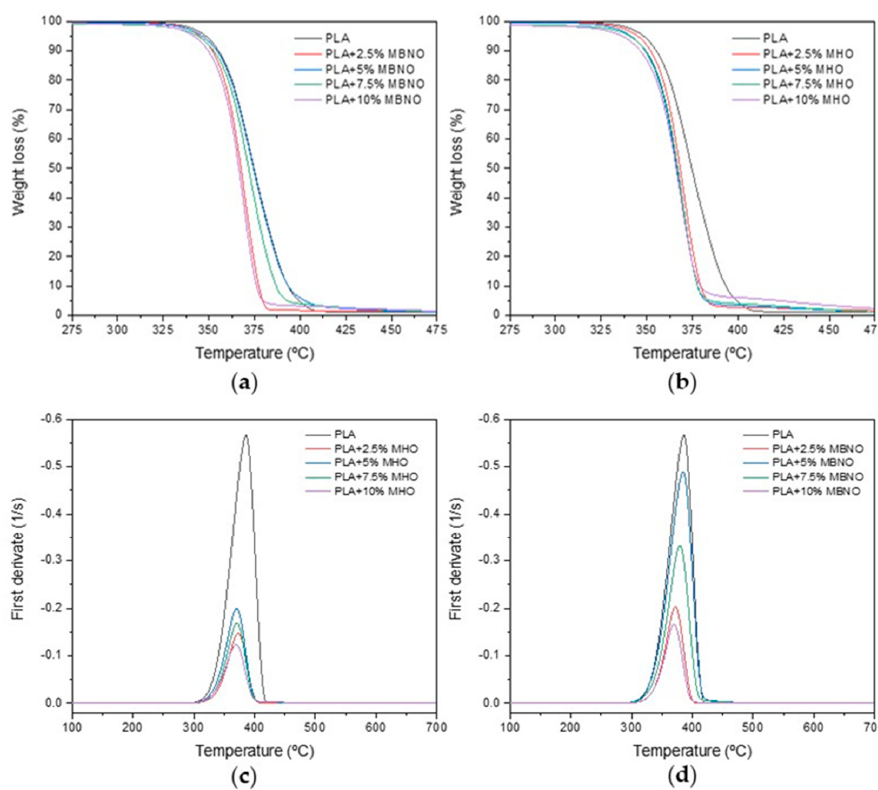
Figure 8. TGA ( a , b ) and DTGA ( c , d ) of unplasticized PLA and PLA plasticized with different content of MBNO and MHO.